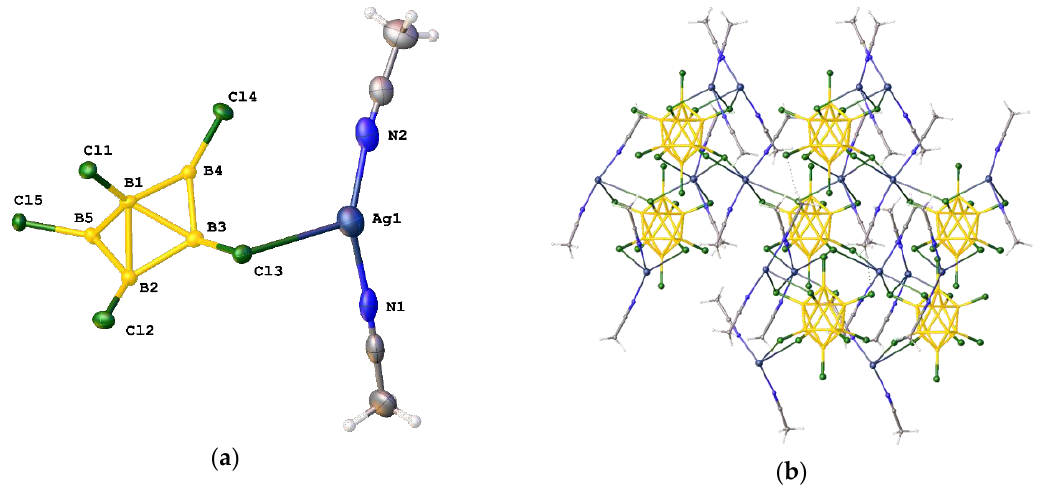
Figure 6. ( a ) Asymmetric unit of 8 in representation of atoms with thermal ellipsoids (p = 50%) and ( b ) fragment of crystal packing of 8 .